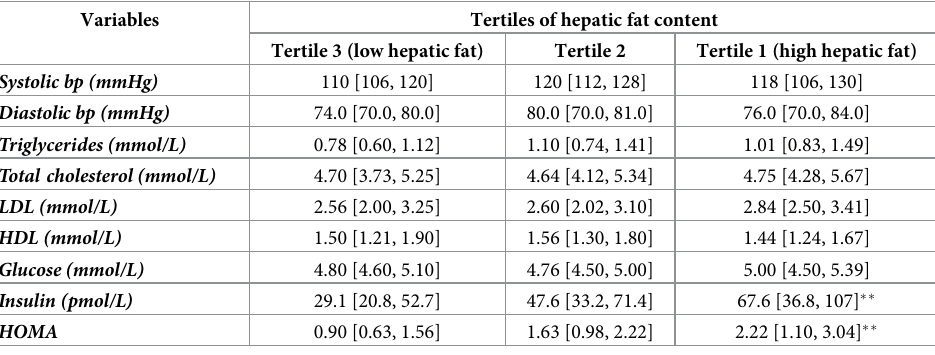
Table 2. Comparison of blood pressure, lipid, glucose, insulin and insulin resistance levels across tertiles of hepatic liver fat content.